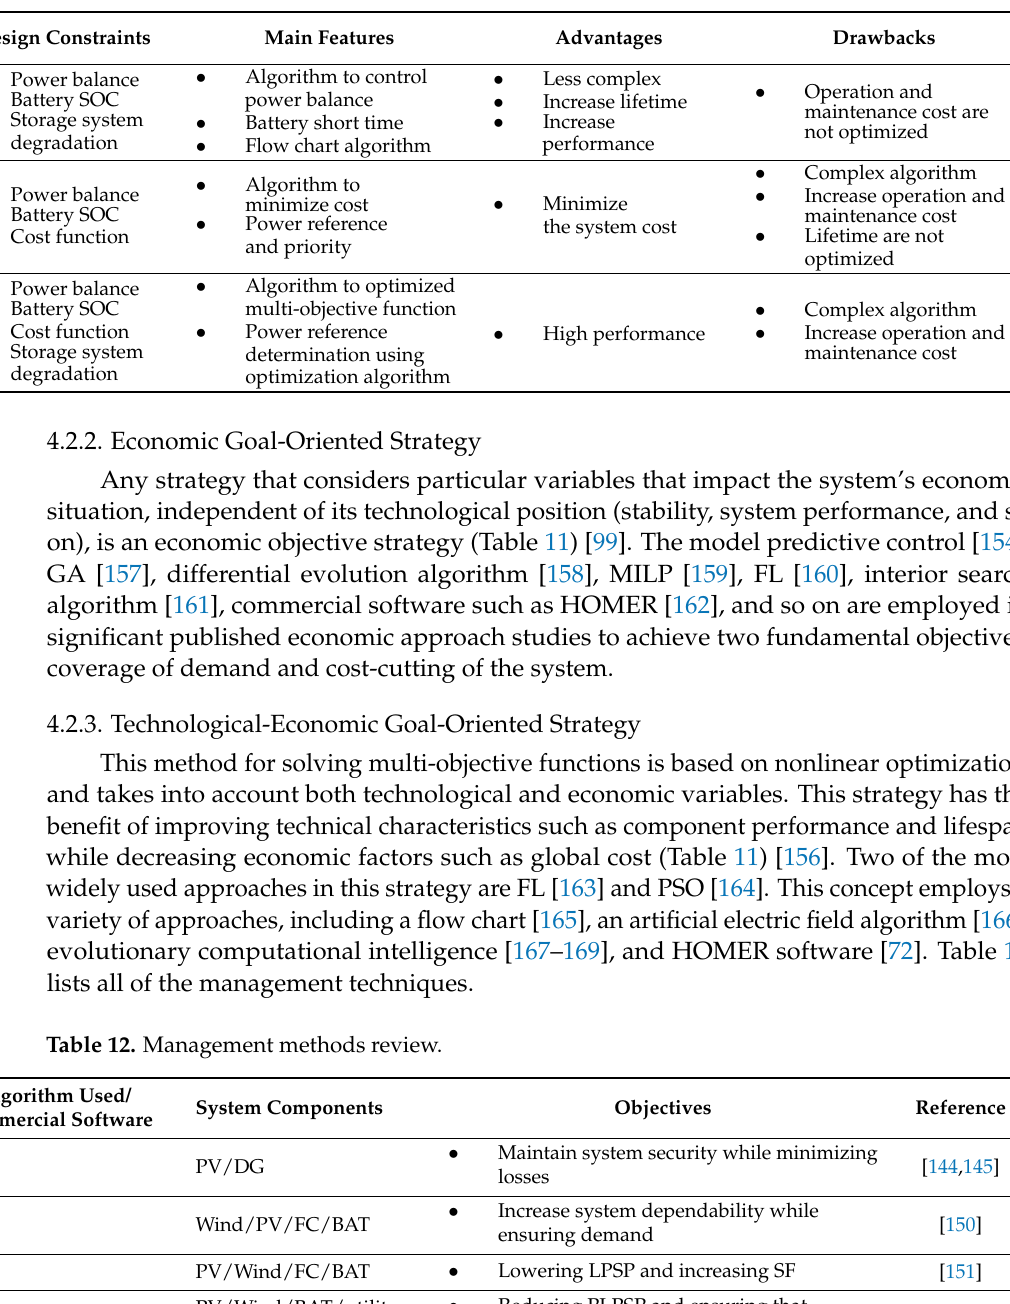
Table 11. Management methods and its characteristics of hybrid system [99,155,156].